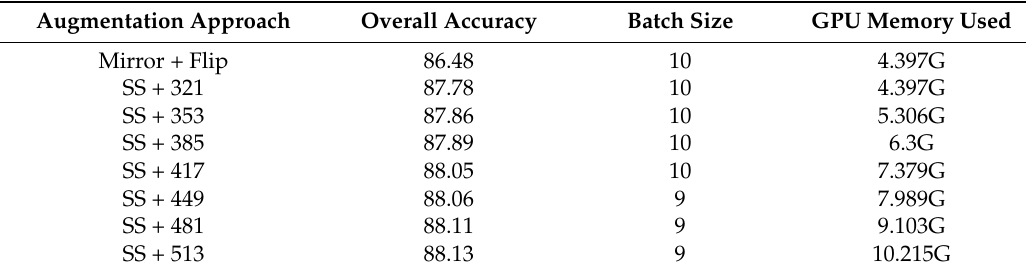
Table 7. Effect of varying the training crop size on the Vaihingen